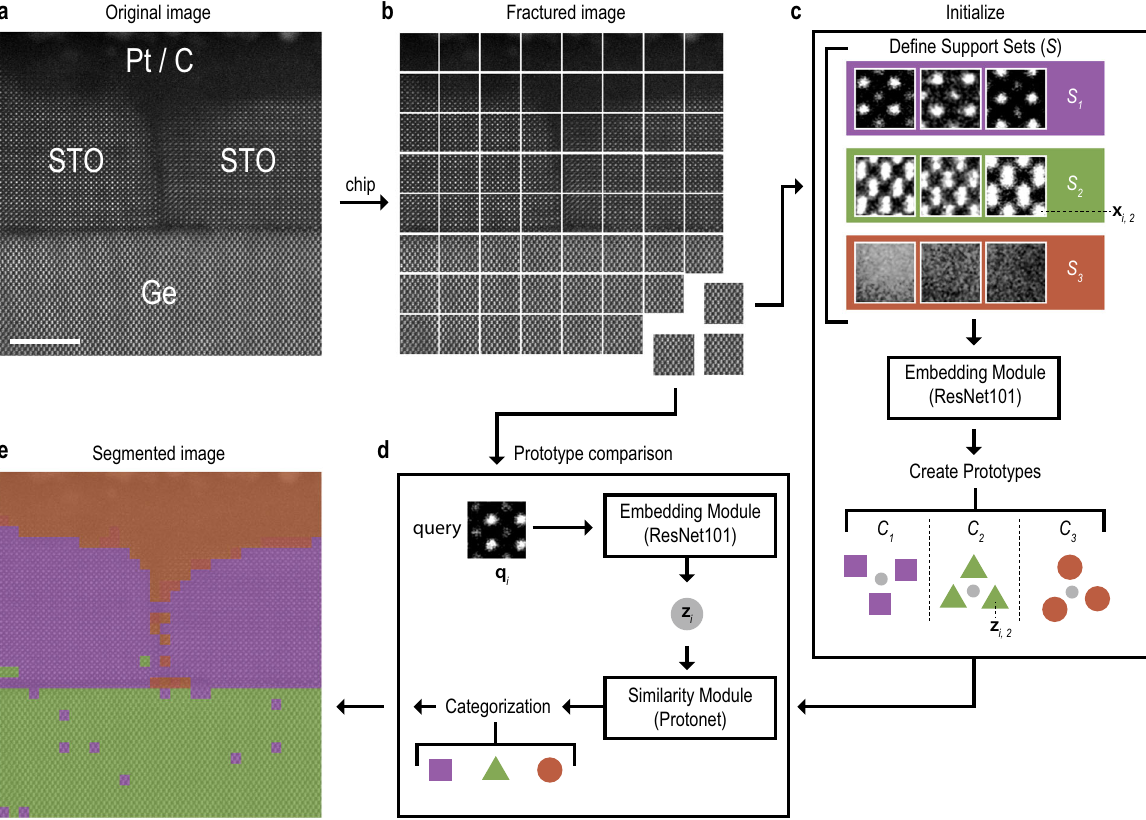
Fig. 1 Few-shot model architecture. The raw STO/Ge image ( a ) is broken into several smaller chips ( b ) and a few user de fi ned chips are used to represent desired segmentation classes in the support set ( c ). Each chip then acts as a query and is compared against a prototype ( d ), de fi ned by the support set, and categorized according to the minimum Euclidean distance between the query and each prototype, yielding the segmented image ( e ). Scale bar = 5